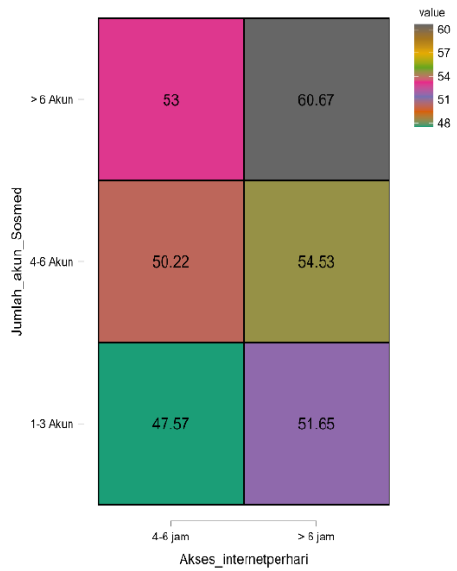
Figure 5. Social Media Addiction Heatmaps Based on Social Media